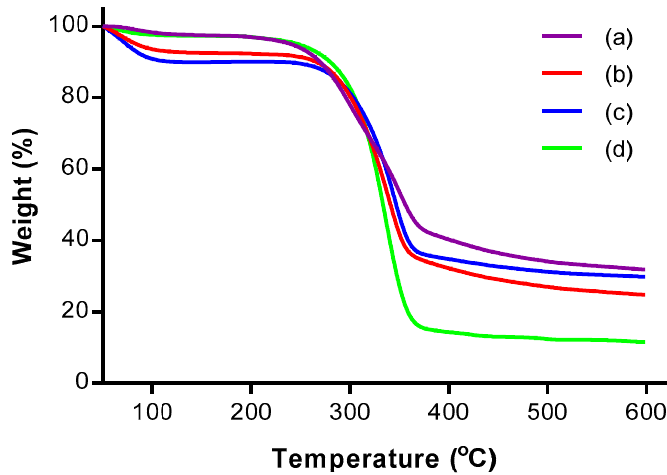
Figure 4. Thermogravimetric (TG) thermograms of (a) OPMF, (b) alkaline treated OPMF, (c) bleached OPMF and (d) CNC.